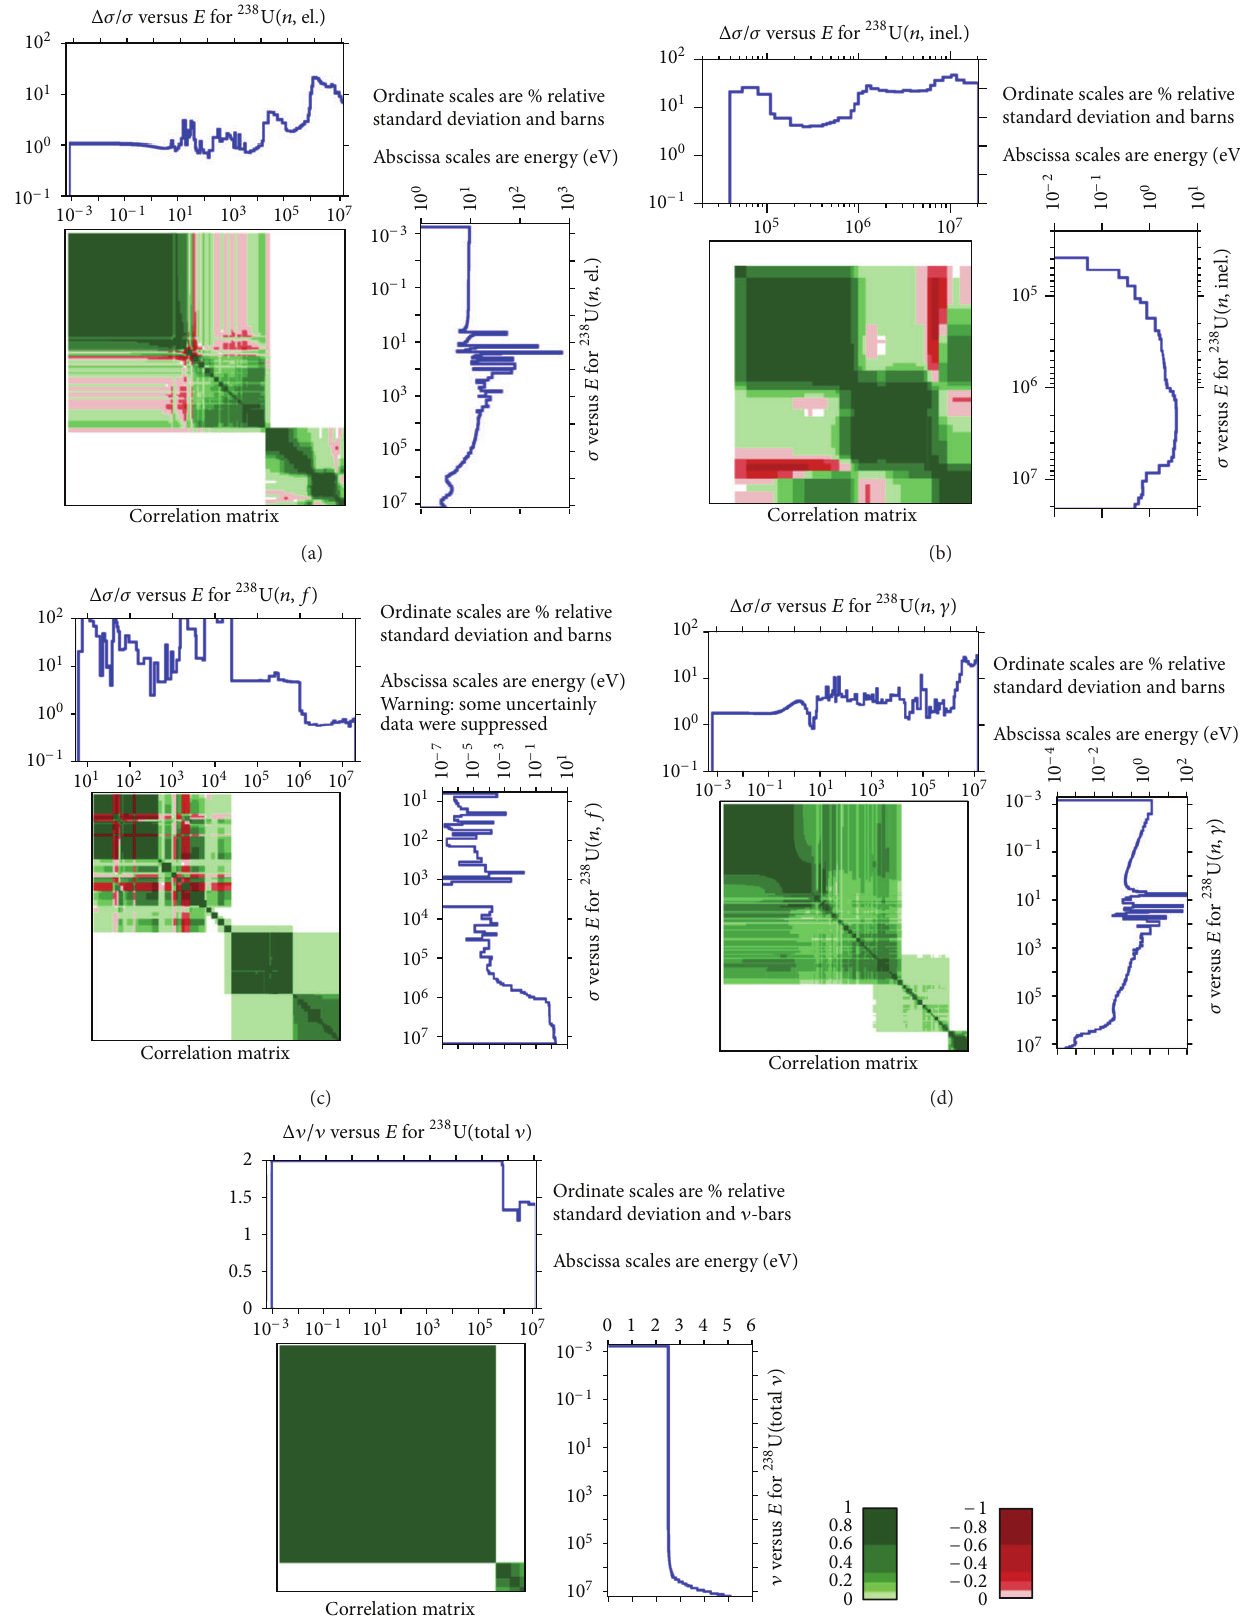
F 7: Covariance plot for based on ENDF/B-VII.1